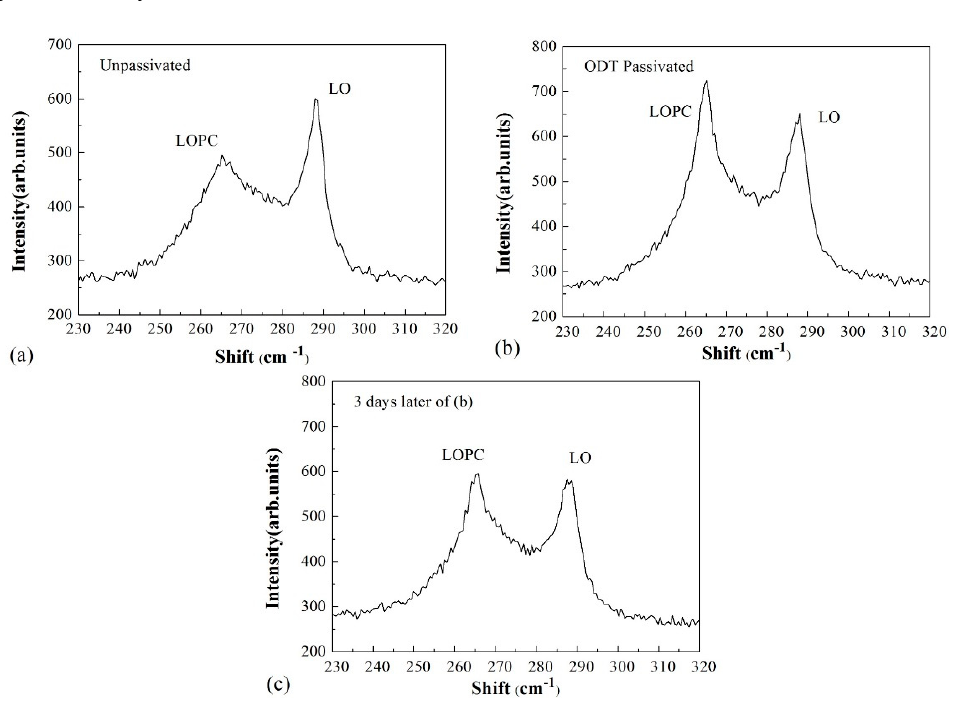
Figure 2. Raman spectra of GaAs (100) surface ( a ) unpassivated, ( b ) ODT passivated, ( c ) exposure in air for 3 days after ODT